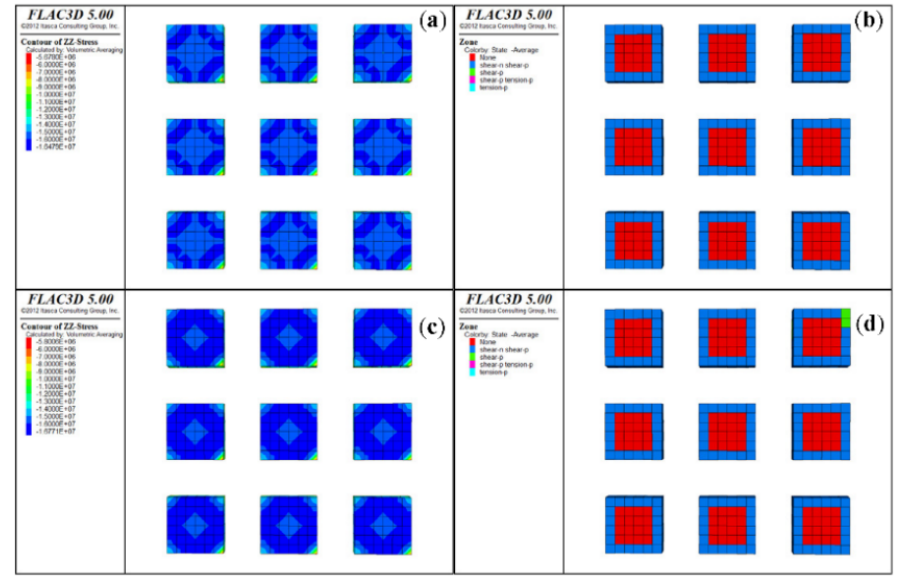
Figure 6. Distribution of the stress and elastic zone with a mining thickness of 1 m and a variable mining width: ( a ) vertical stress of 160 m width; ( b ) elastic zone of 160 m width; ( c ) vertical stress of 240 m width; ( d ) elastic zone of 240 m width.